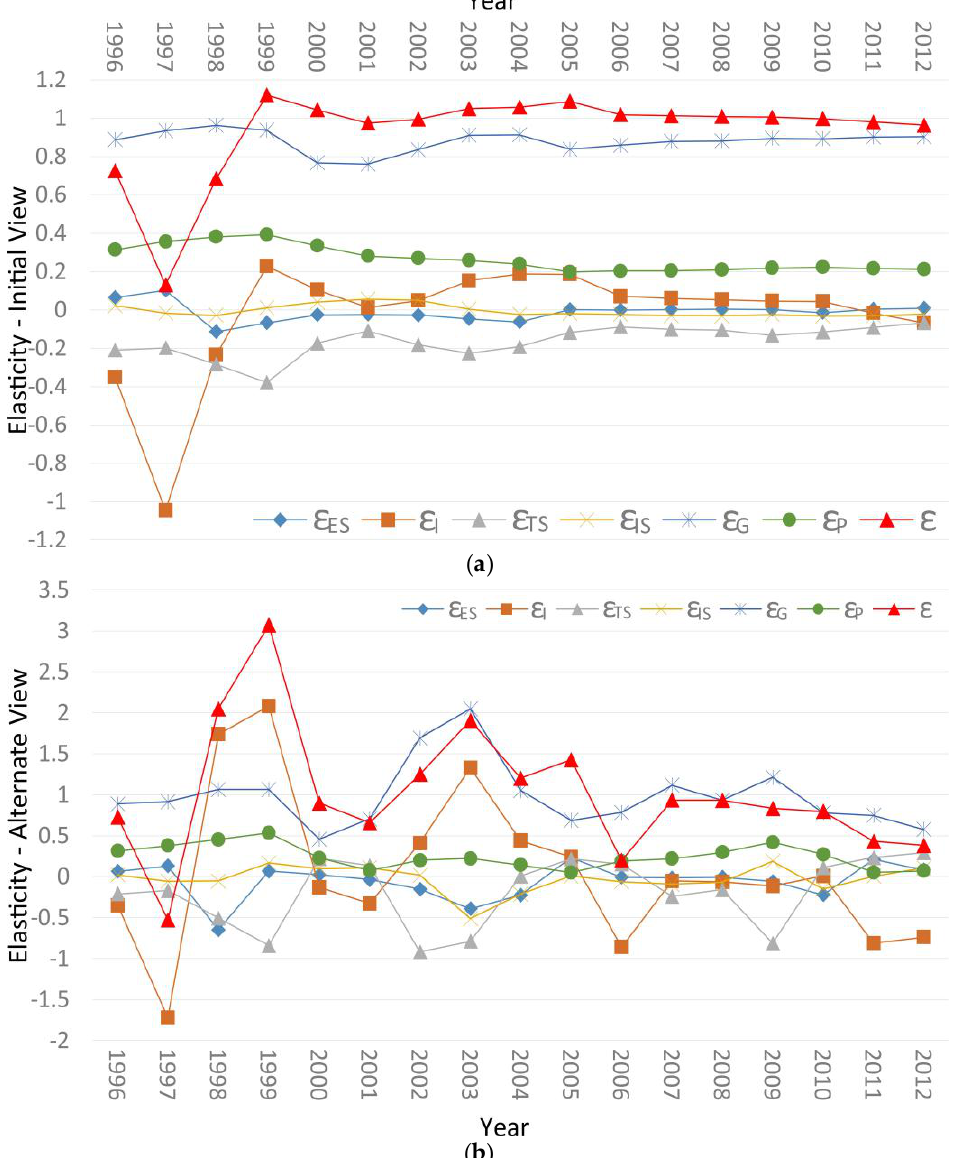
Figure 4. Decoupling elasticity index and its components of the transport sector in Guangdong, in the initial view ( a ) and alternate view ( b ).